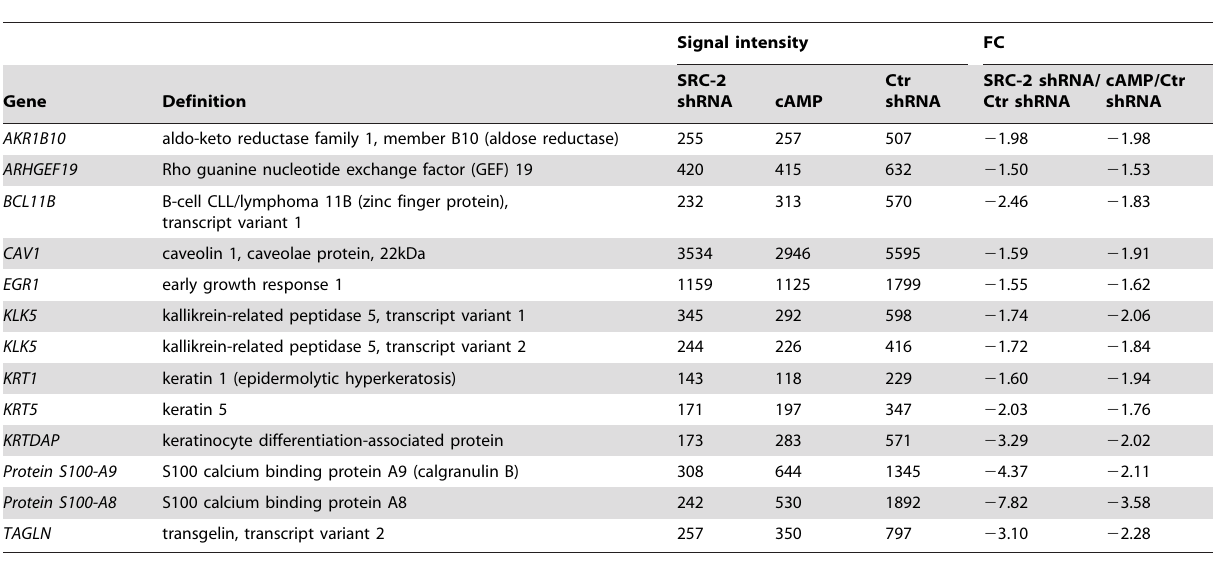
Table 1. Overlapping decreased expression changes relative to control induced by SRC-2 KD and cAMP in MCF-7 cells.